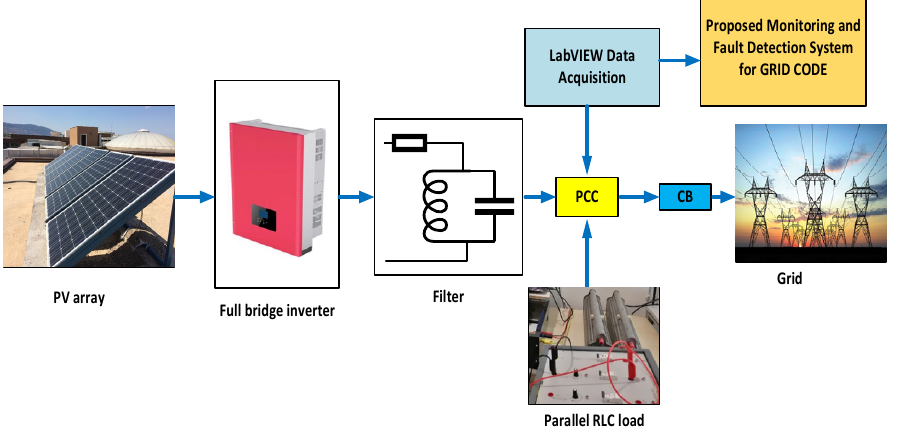
Figure 1. The general structure of a grid-connected PV system. Islanding, which is defined as the loss of the main grid, causes the voltage and frequency of the grid to suddenly go out of the nominal operating conditions. This will damage the DG system components, render the system inoperable (blackout), and endanger the life safety of the operator if an operator is working in the DG system. For this reason, when an undesired islanding event of DG systems occurs, the DG system must disconnect from the mains as soon as determined by the standards